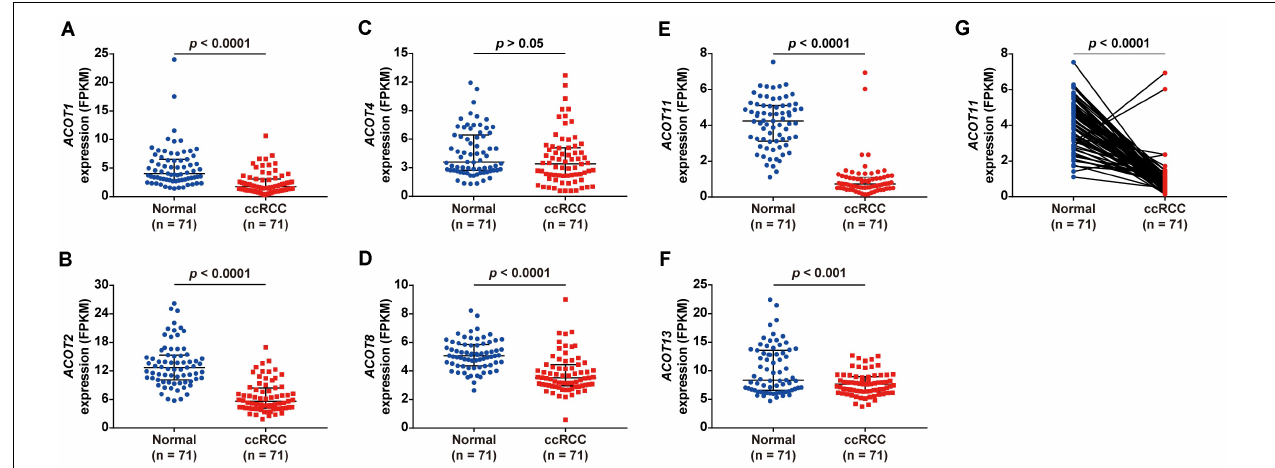
FIGURE 1 | Different ACOTs expressions in 71 ccRCC normal-tumor pairs from TCGA database. ACOT1/2/8/11/13 were significantly downregulated in ccRCC, while the transcriptional expression of ACOT4 was not significantly different between these two groups (A–F) . ACOT11 expression obviously decreased in most matched samples (G) . p- Value < 0.05 was considered as statistically